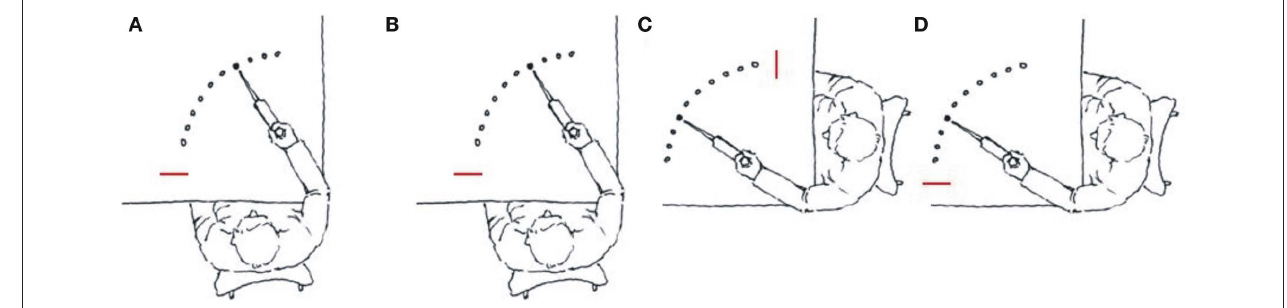
( Figure 2A ). The task required the participants to move a lever as quickly and smoothly as possible to the illuminated target position by flexing or extending their arm at the elbow. Upon “hitting” the target (by moving the pointer attached to the lever into the target area) the illumination was turned off and the next target in the sequence was immediately illuminated. Ten repetitions of the 14-element sequences were provided in each block and each day of practice involved 16 blocks of practice. Over practice, partici- pants appeared to impose a structure on the movement